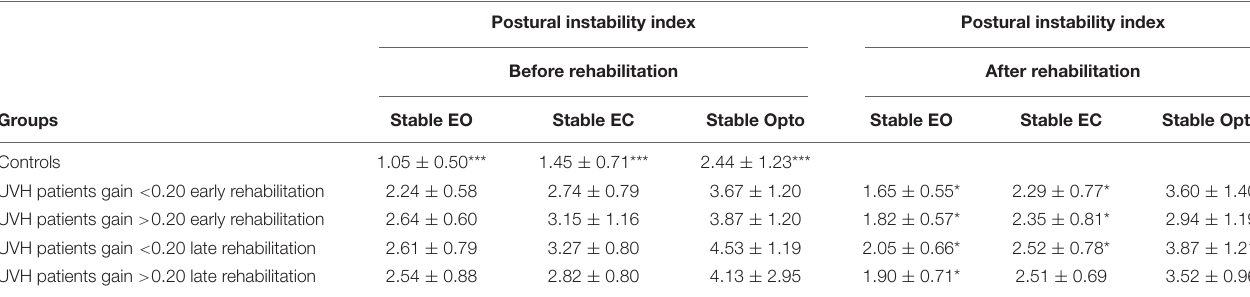
TABLE 2 | Effect of vestibular rehabilitation on patients’ posture stability in static posturography